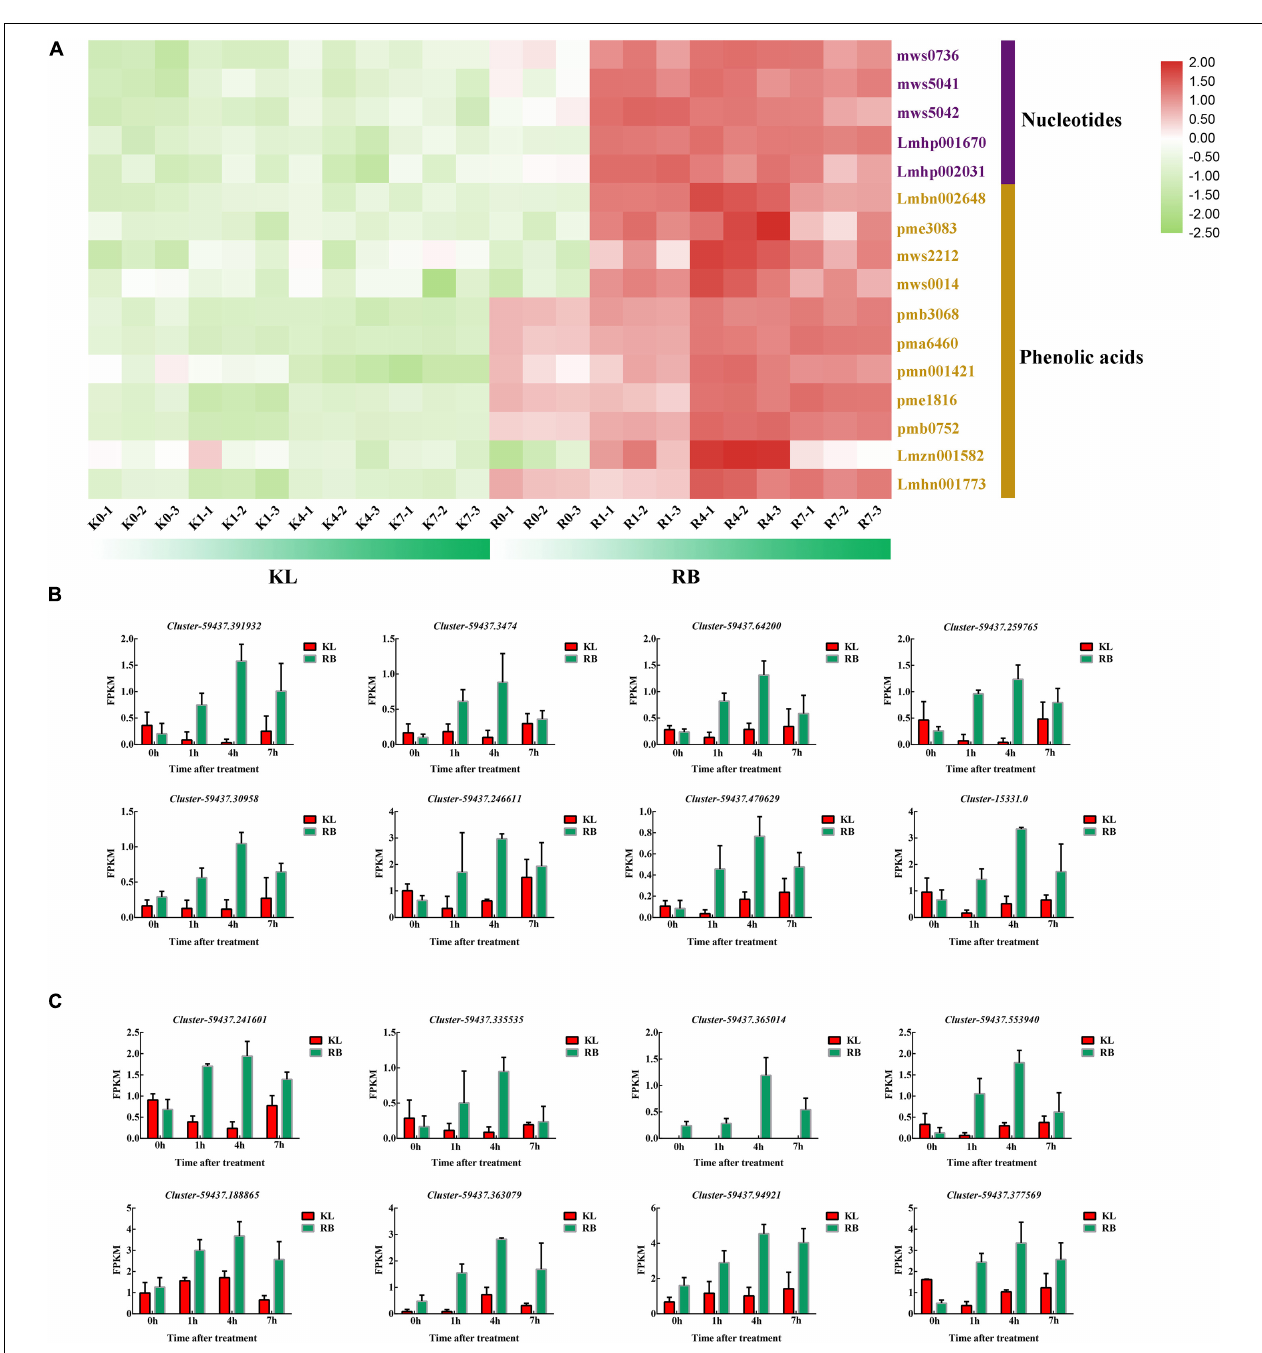
FIGURE 9 | The DEMs and DEGs involved in the phenolic acids mechanism and nucleotides metabolism pathways. (A) Heat map of phenolic acids and nucleotides that specifically accumulated in the KL genotype. (B) Candidate DEGs involved in the nucleotides metabolism pathway. (C) Candidate DEGs involved in phenolic acids metabolism